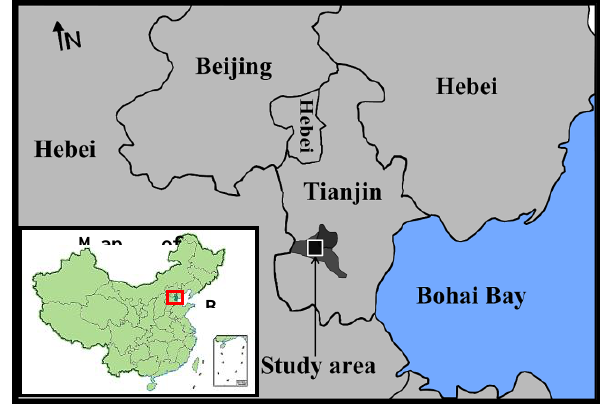
Fig. 2 Averaged amplitude image of the study area with annotation of highways, railway line and the LPs. Four highways and one railway line as annotated with AA', BB', CC', DD' and EE' are selected for further